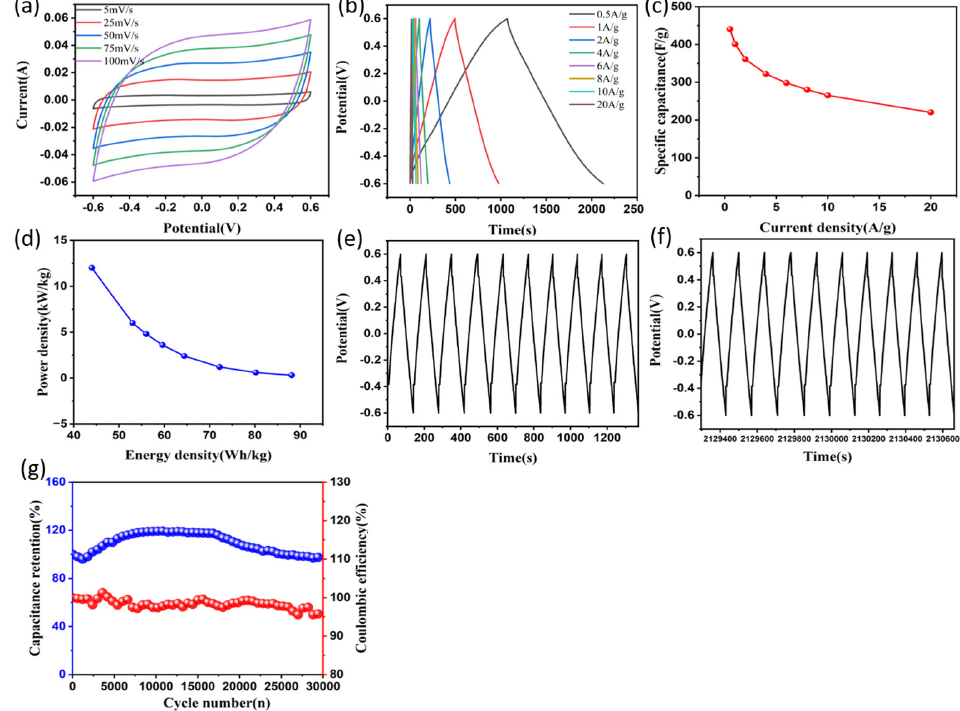
Figure 8. ( a ) CV curves of the symmetric SC under different scan rates; ( b ) GCD curves of the SC at different current densities; ( c ) specific capacitances of the SC at different current densities; ( d ) Ragone plot related to power and energy densities of the SC; ( e , f ) the GCD curves for the first 10 cycles and the last 10 cycles out of 30,000 cycles; ( g ) the capacitance retention and Coulombic efficiency at a current density of 10 A/g for 30,000 cycles; The electrolyte for all the above electrochemical tests was 6 mol/L KOH solution.